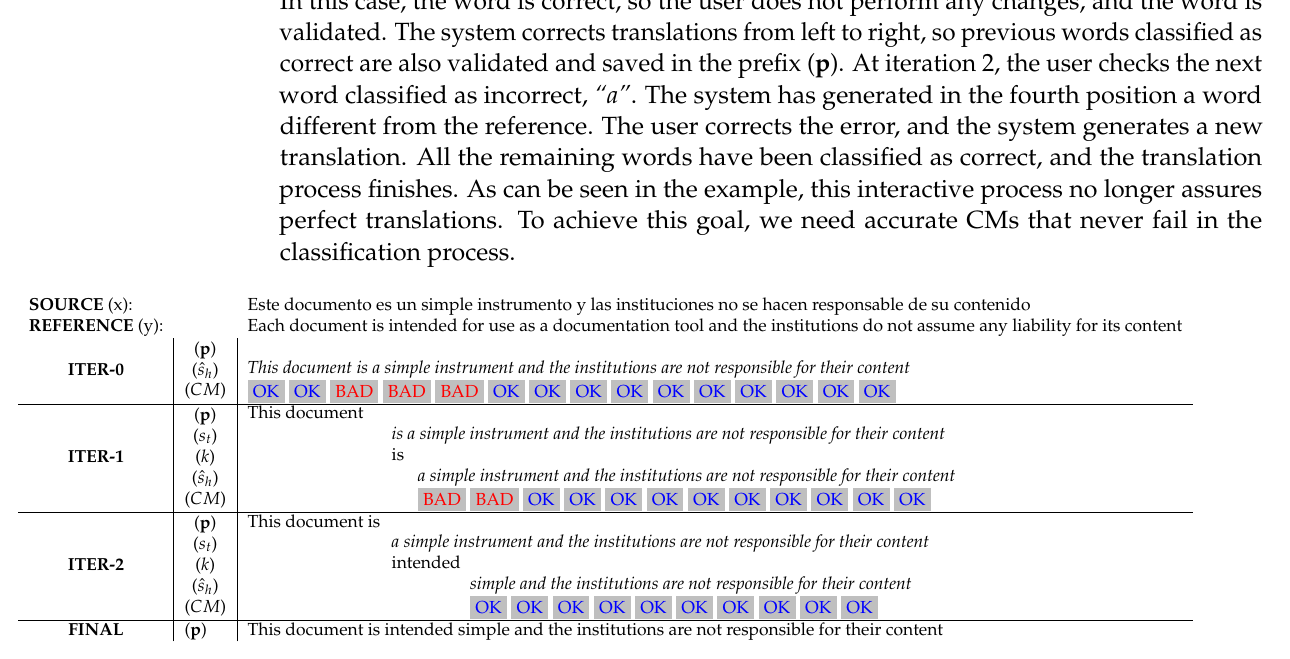
Figure 1. Example of a conventional prefix-based IPNMT session with CMs to translate a sentence from Spanish to English. At iteration 1, the user checks a word mistakenly classified as incorrect. At iteration 2, the word “a” is corrected and the system generates a new hypothesis. Non-validated hypotheses are displayed in italics , and accepted prefixes are printed in normal